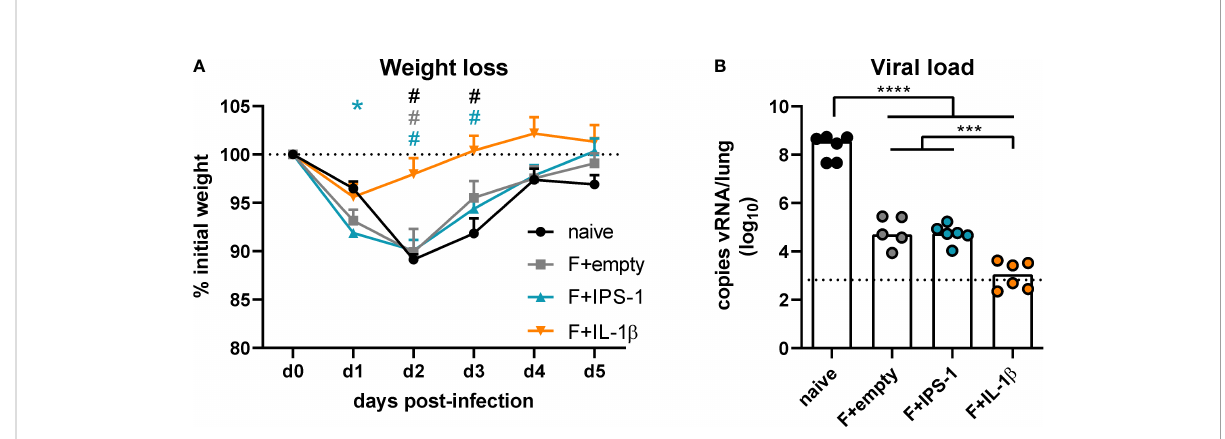
FIGURE 3 Vaccine ef fi cacy against RSV infection. Mice were experimentally infected with 1x10 6 PFU RSV-A2 48 days after the immunization. (A) The initial weight was set as 100% (dotted line) and weight changes were monitored for fi ve days. (B) Viral RNA copies were quanti fi ed by qRT-PCR in lung homogenates fi ve days post-infection. The dotted line represents the lower limit of quanti fi cation. Data represent group means with SEM (A) or group medians overlaid with individual data points (B) . n=5-6. Data were analyzed by one-way ANOVA followed by Tukey´s post test (values in B were log-transformed before analysis). For (A) : * p <0.05 vs . naive, # p <0.05 vs . F+IL-1 b . For (B) : * p <0.05, ** p <0.005, *** p <0.0005, **** p